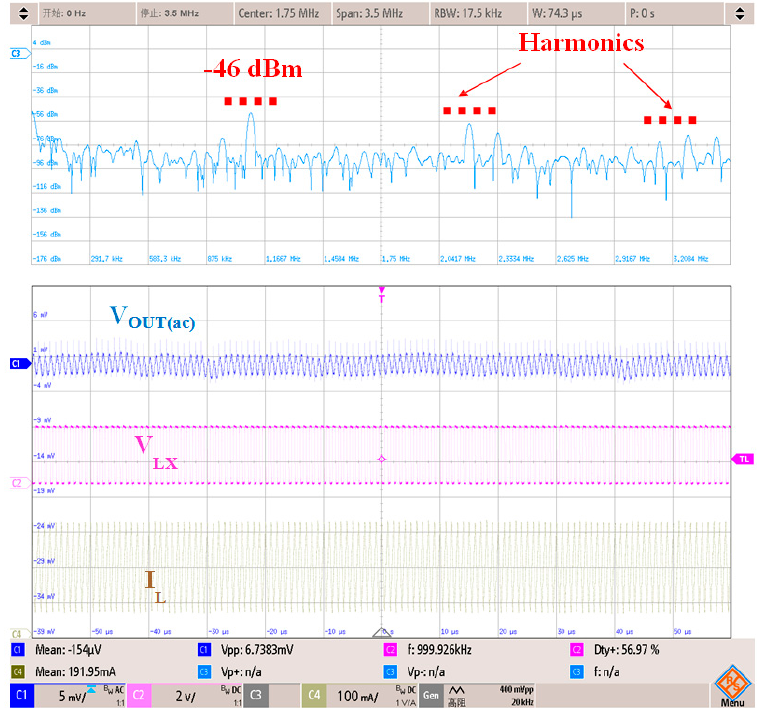
Figure 17. Measured spectrum waveform without the proposed triangular spread-spectrum mechanism.